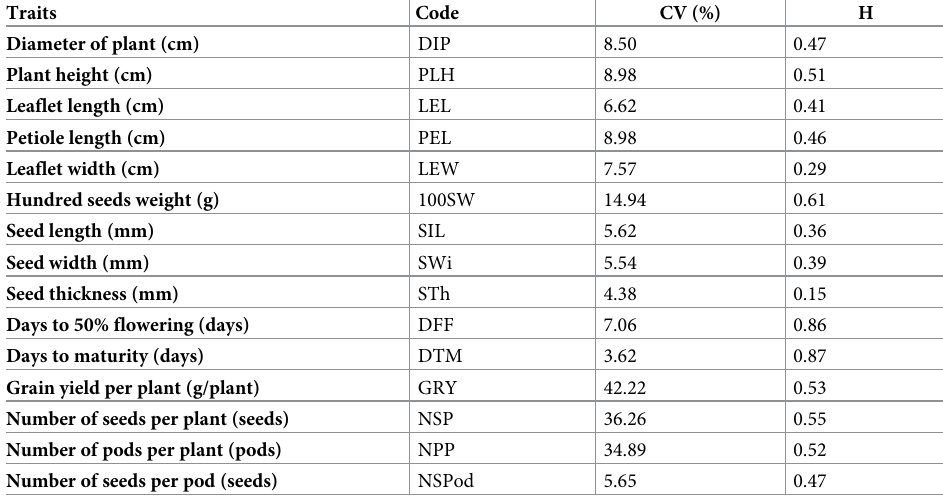
Table 4. Coefficients of variation and broad sense heritability estimates of Kersting’s groundnut morphological traits across Sekou and Sav è environments.